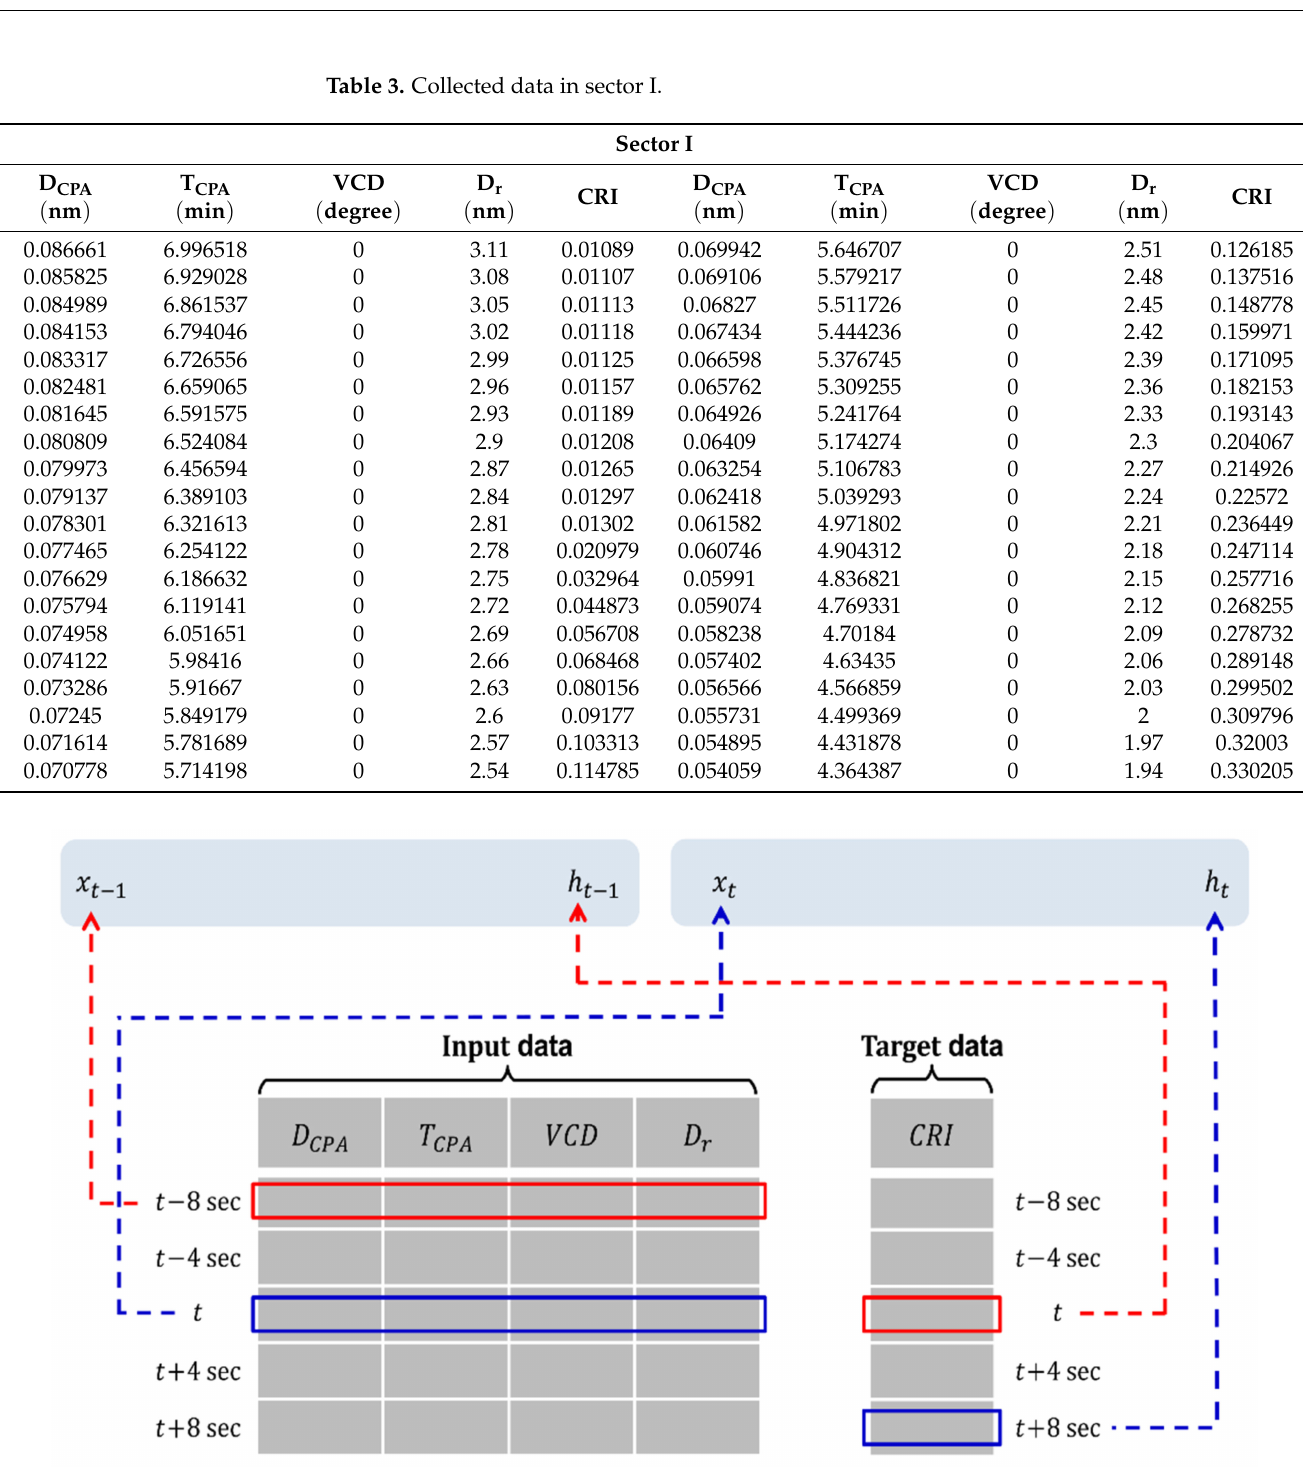
Figure 9. Schematic of the sequence model used for learning